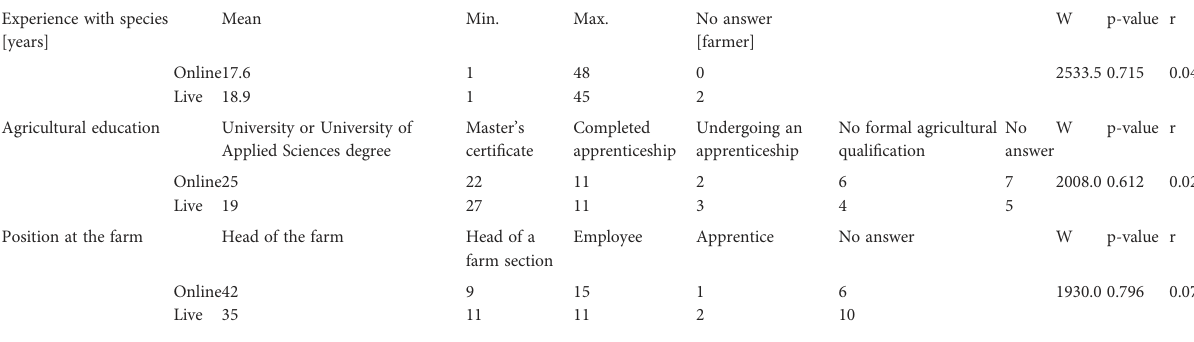
TABLE 3 Comparison of the farmers ’ professional backgrounds between the online and live training groups. Experience with species